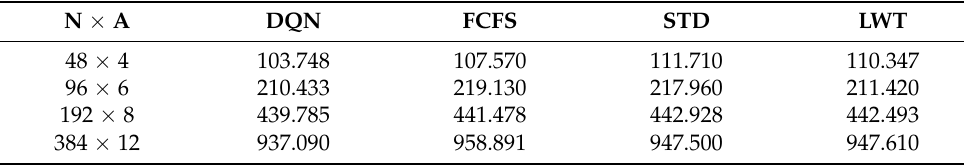
Table 7. Total completion time of AGVs (min) under different scales.